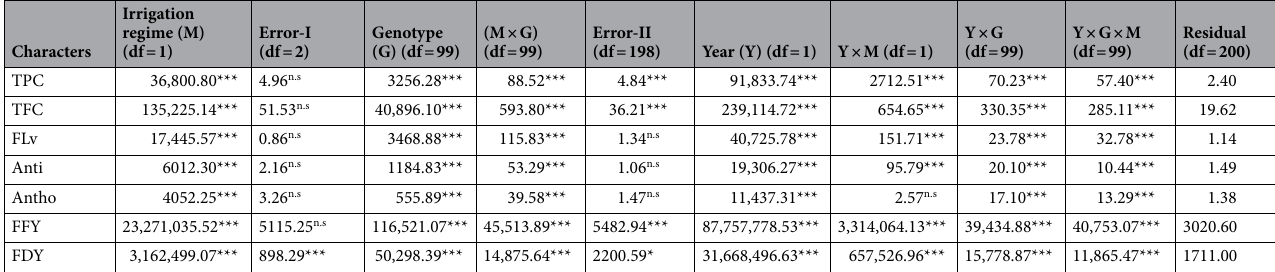
Table 3. Mean squares and source of variations in combined analysis of variance for traits evaluated in non- stress and drought stress in 100 of Poa pratensis accessions in 2018 and 2019. n.s, * and *** represent non- significant and significant at P < 0.05 and P < 0.001, respectively. M, moisture environment; G, genotype; Y, year, error I = R(M); EII = R × G(M); TPC, total phenol content; TFC, total flavonoid content; FLv, flavanone; Anti, antioxidant activity; Antho, anthocyanin; FFY, forage fresh yield; FDY, forage dry weight.